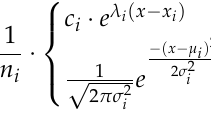
Figure 2. Measurements of TLC flash memory in different life-cycle states